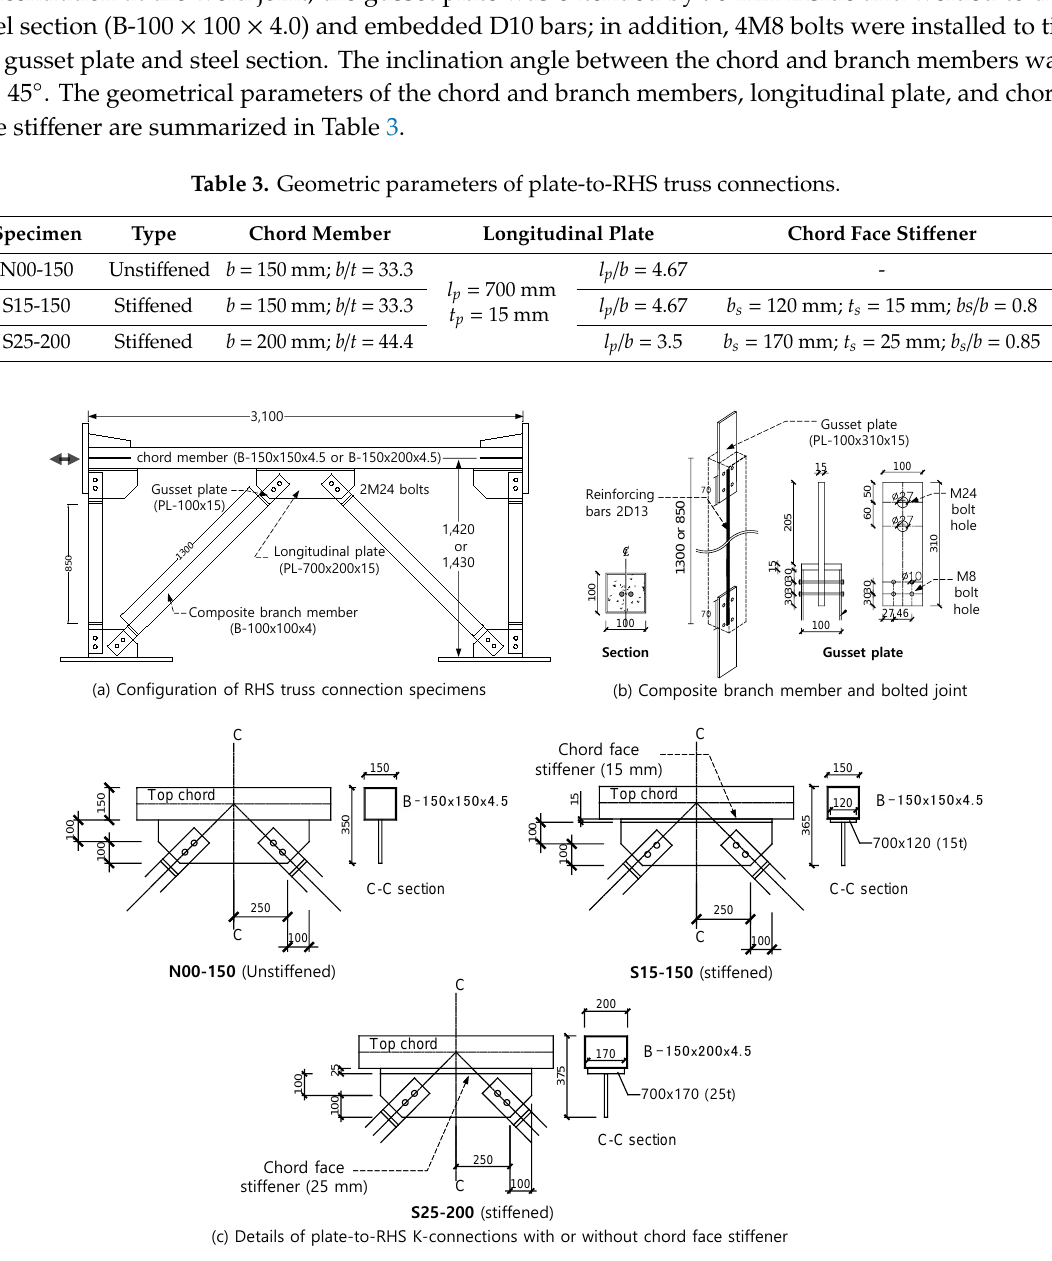
Figure 4. Configuration and connection details of truss specimens with plate-to-RHS K-connection (unit: mm): ( a ) Configuration of RHS truss connection specimens; ( b ) Composite branch member and bolted joint; ( c ) Details of plate-to-RHS K-connections with or without chord face stiffener.